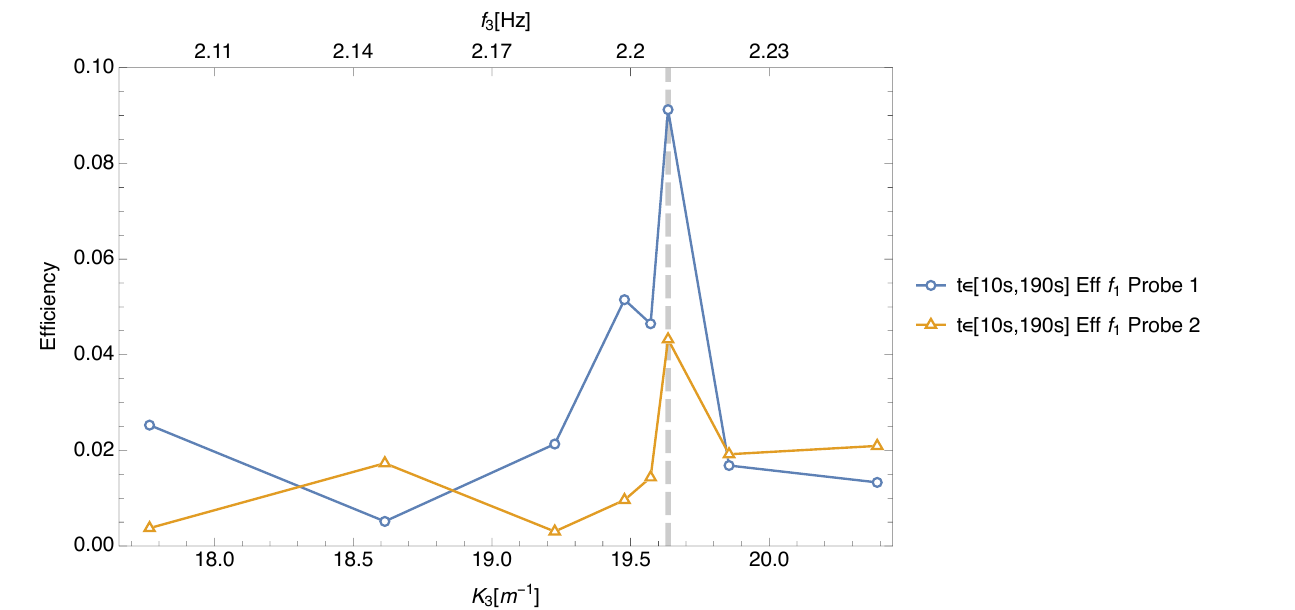
Figure 11. Efficiency as a function of the numerical experiment, for each probe, parameterised by the corresponding wavevector K 3 , for the encountering wavepackets case for a long time series [0, 200 s]. The efficiency is defined as the sum of the squares of the scaleogram signals in Figure 10, on a strip of width 0.05 f 1 about f 1 and between the vertical lines in the figure, divided by the sum of squares over the whole range of frequencies, including f 2 which is not shown. An efficiency of 0.10 corresponds to 10% efficiency. The dashed grey vertical line corresponds to the theoretical resonant case K 1 : K 2 : K 3 = 16 : 9 : 25.